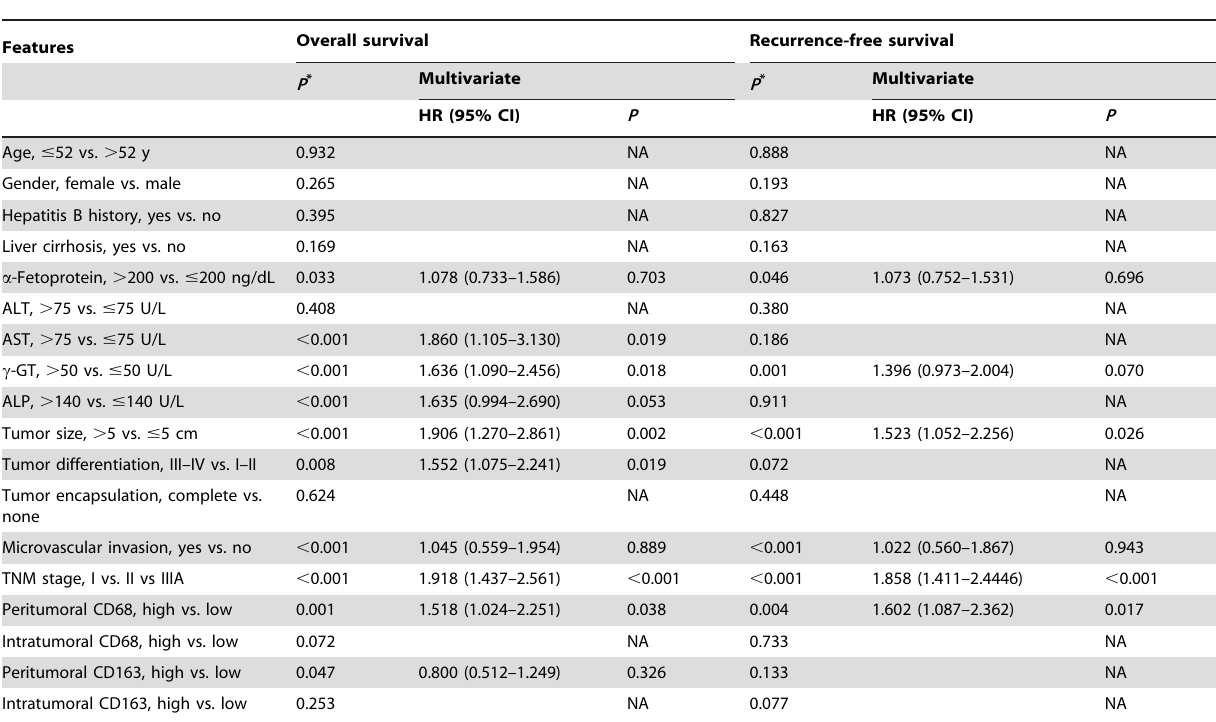
Table 4. Univariate and multivariate analyses of factors associated with survival and recurrence.